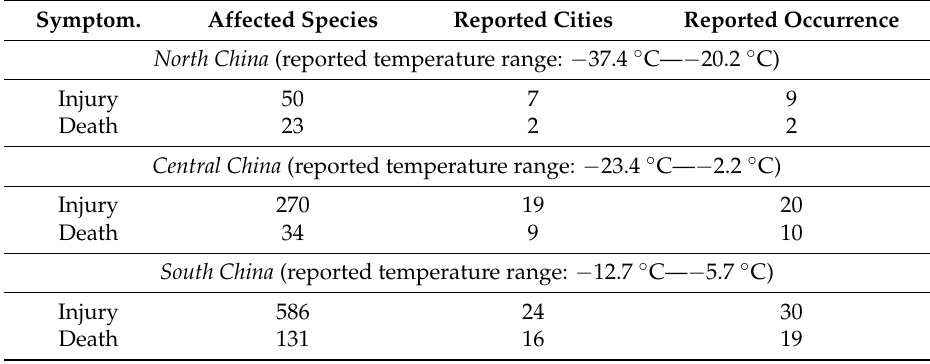
Table 2. Summary of impacts caused by low temperature on urban tree species in China.